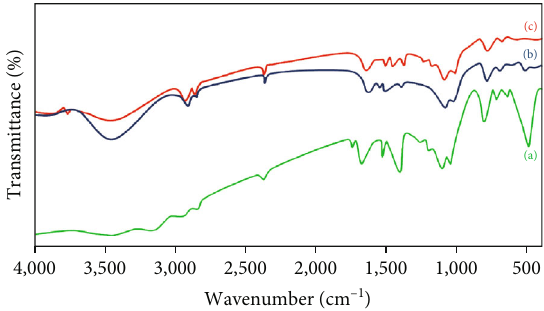
Figure 5: Infrared spectra of (a) virgin epoxy coating, (b) 5% titanium-embedded epoxy coating, and (c) 10% titanium- embedded epoxy coating after natural exposure testing at NIO.